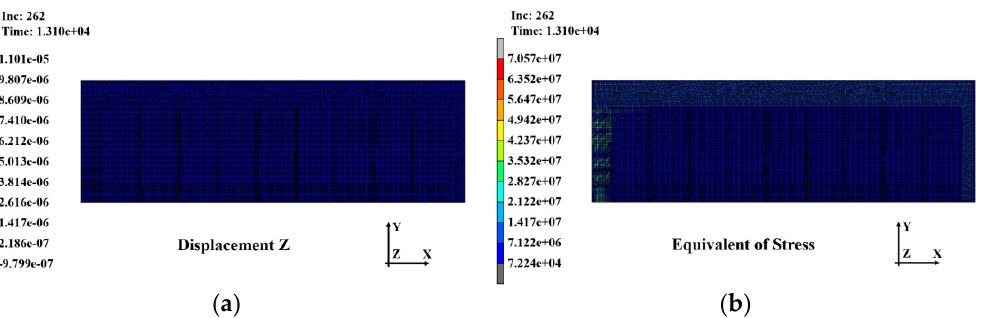
Figure 19. Analysis results of substrate after the third laminating: ( a ) warpage distribution (11.01 μ m); ( b ) stress distribution (70.57 MPa).